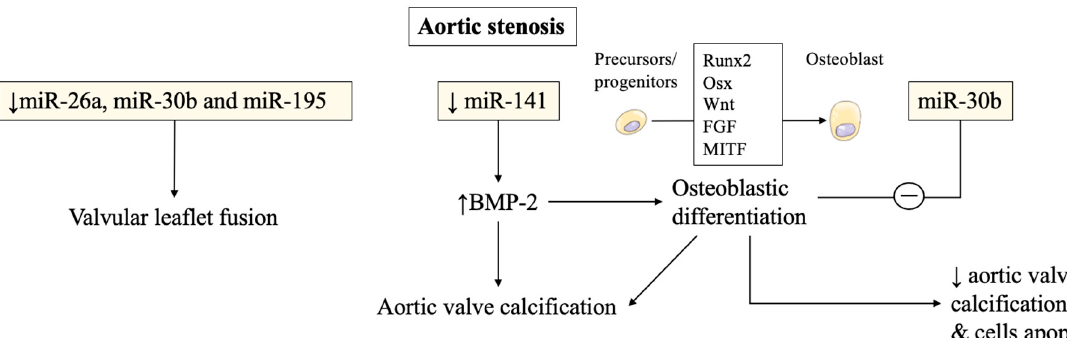
Figure 1. The role of miRNAs in aortic stenosis severity and valve calcification. Reduced levels of miR-26a, miR-30b, and miR-195 contribute to further damage to the valve. The negative regulation exerted on osteoblastic differentiation by miR-30b favors a better prognosis, in terms of a decrease in valve calcification. On the other hand, reduced levels of miRna-141 guarantee osteoblastic calcification processes via increasing BMP-2 levels, a relevant factor involved in bone production. Osteoblasts differentiate from precursors and progenitors through several factors, including Runx2 and Wnt. This differentiative process negatively affects valves elasticity by contributing to their calcification. BMP: bone morphogenetic protein. Runx2: RUNX Family Transcription Factor 2, OSX: osterix factor, FGF: Fibroblast growth factor, MITF: Microphthalmia-associated transcription factor.